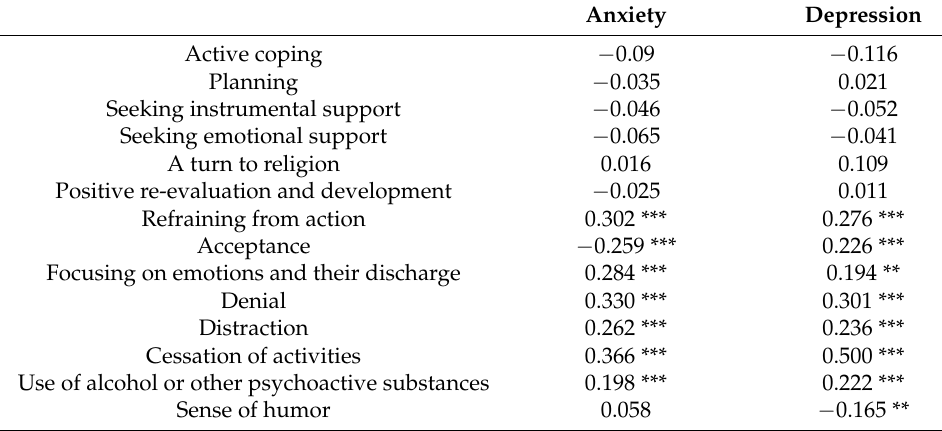
Table 11. Correlations between the HADS and MiniCOPE